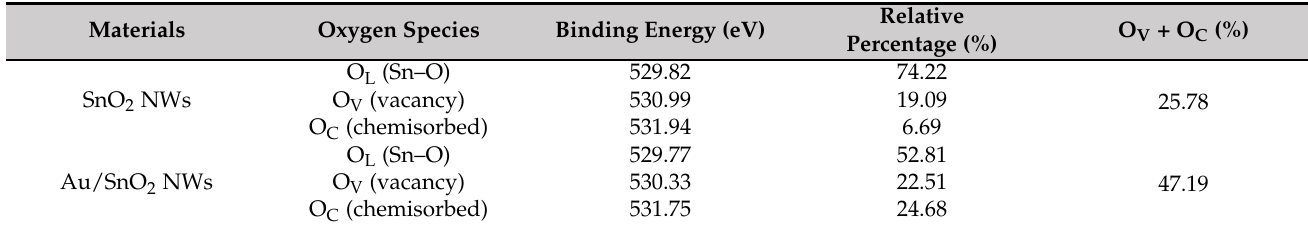
Table 1. The conclusive fitting results of O 1s XPS spectra of SnO 2 and Au/SnO 2